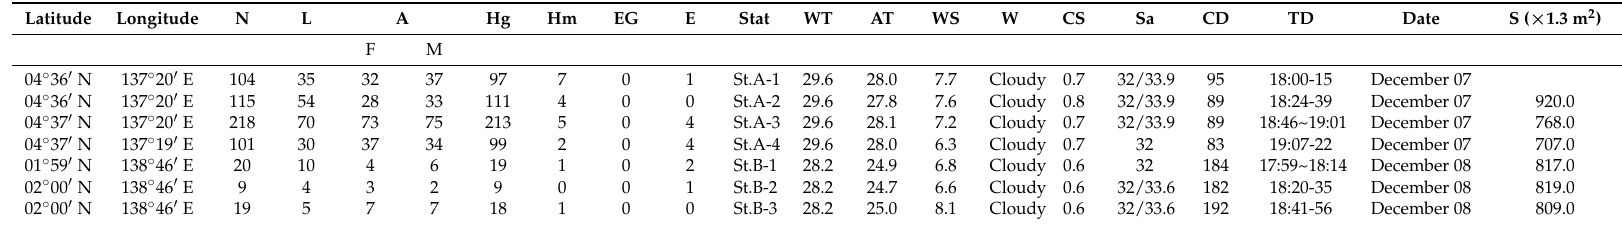
Table 1. Number of oceanic sea skaters, Halobates , collected at locations in the tropical Pacific Ocean on 7–8 December2016,during the science cruise, MR16-08 (N: total number of individuals collected; H.g.: Halobates germanus , H.m. : H. micans ; Stat: station number; WT: water temperature (°C); AT: air temperature; L: number of larvae; A: number of adults, E: number of exuviae; EG: number of eggs (on substrates such as polystyrene form); Date: sampling date; Sampling was performed for 15 min; Sa: salinity (‰); S: surface area swept by the neuston net expressed as the value of the flow-meter × 1.3 m 2 of the width of the neuston net; WS: wind speed (m/s); W: weather; TD: time of day; CS: current speed (m/s); CD: current direction; F: female; M: male. No other species of oceanic sea skaters was collected in this area.